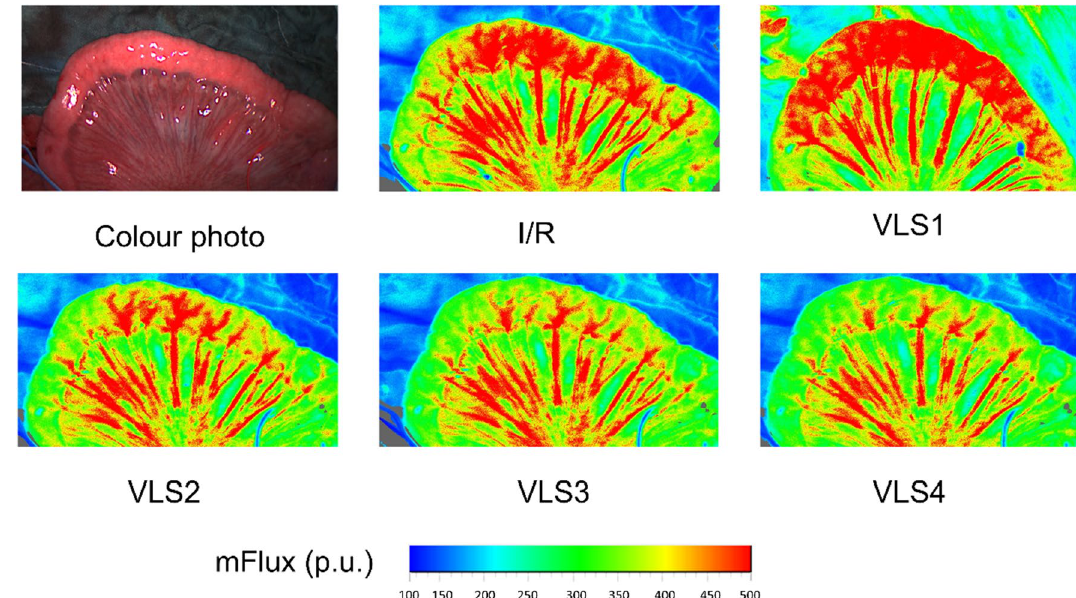
Figure 2. Sample picture of small intestine and color-coded examples of Laser-Speckle-Contrast-Imaging. Sample picture of exposed small intestine (ileum) and color-coded examples of Laser-Speckle-Contrast-Imaging derived mean intestinal microcirculatory blood flow (mFlux) at all points of measurement in an exemplary animal. I/R = ischemia/reperfusion; VLS = volume-loading-step.